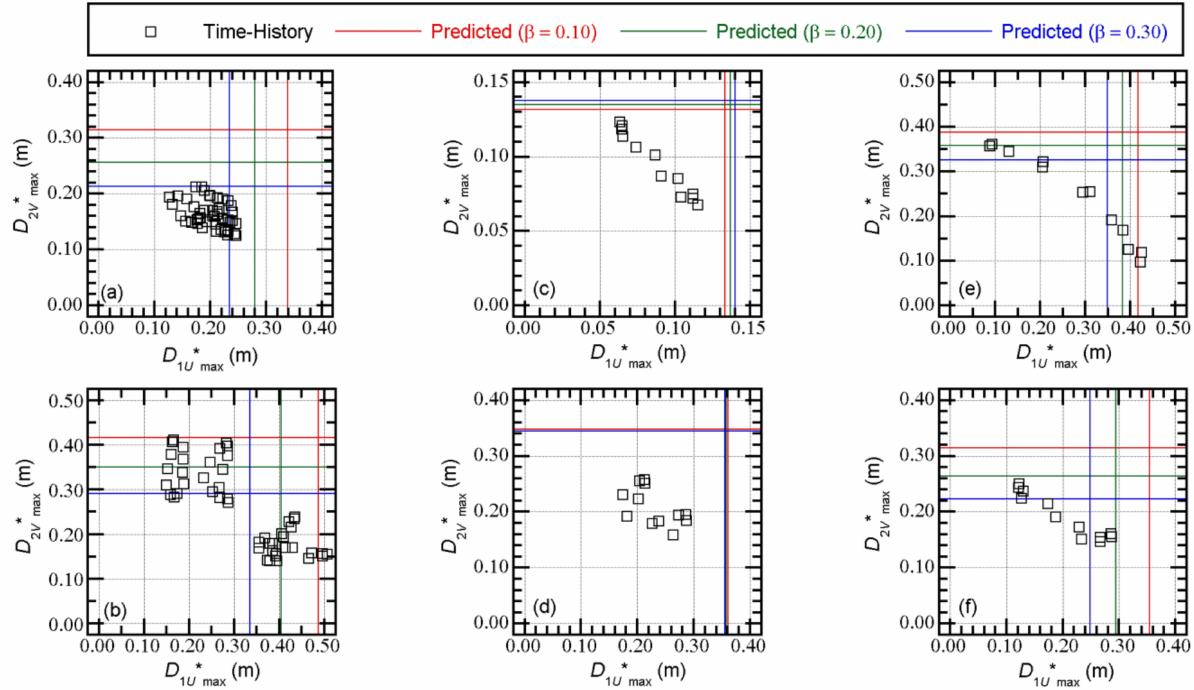
Figure 38. Accuracy of the predicted peak equivalent displacements of the first two modes (Model-Tf44): ( a ) Art-1 series;